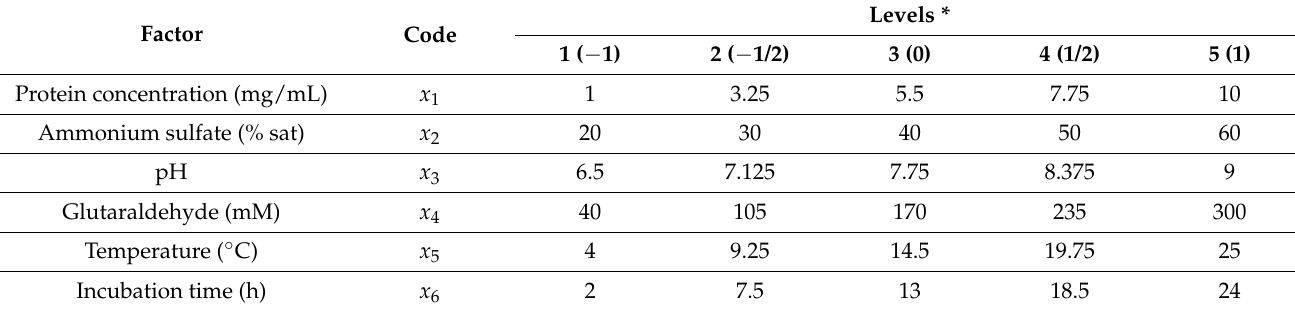
Table 1. Factor and levels for investigating the production of the LipMatCCR11-CLEAs.